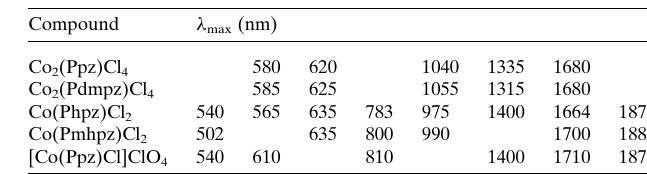
Table 5 Principal absorption bands in the visible and near-IR regions.